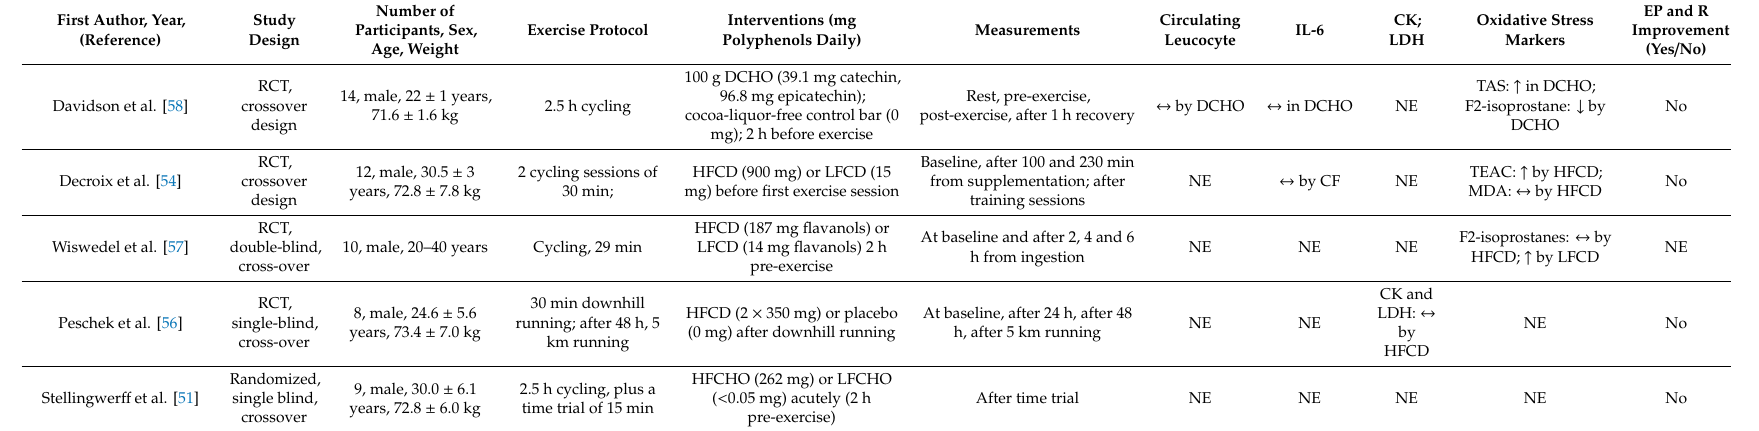
Table 1. Acute e ff ects of cocoa polyphenols on exercise-mediated oxidative stress, inflammation, and exercise